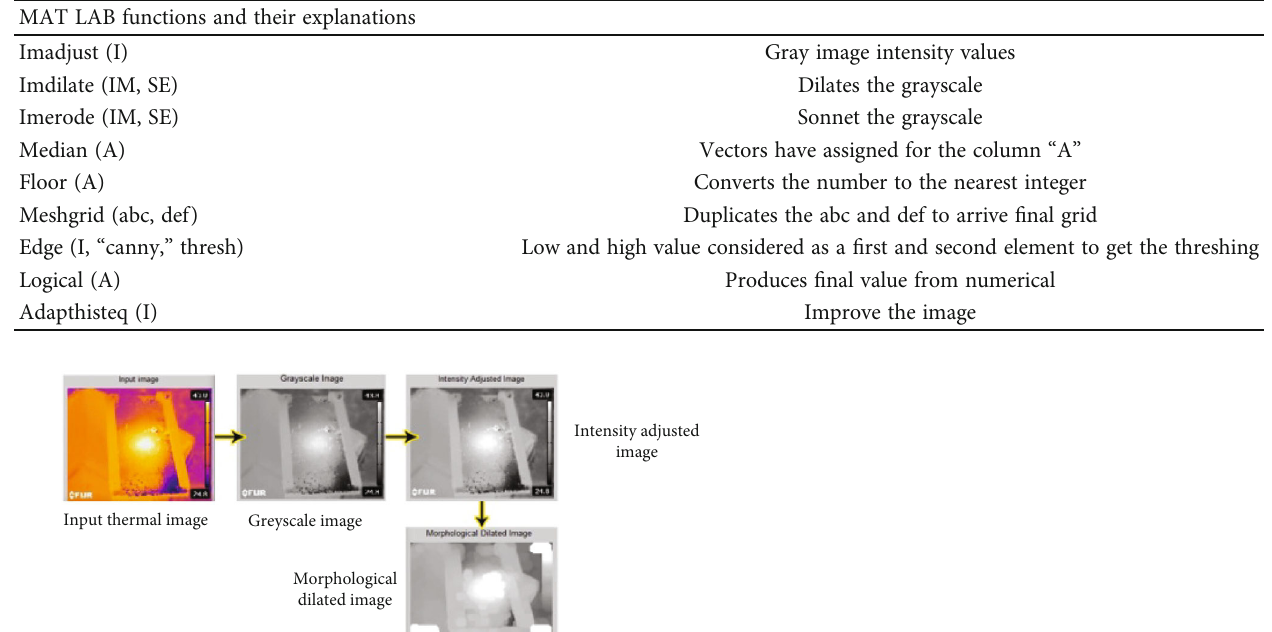
Table 1: MATLAB functions.